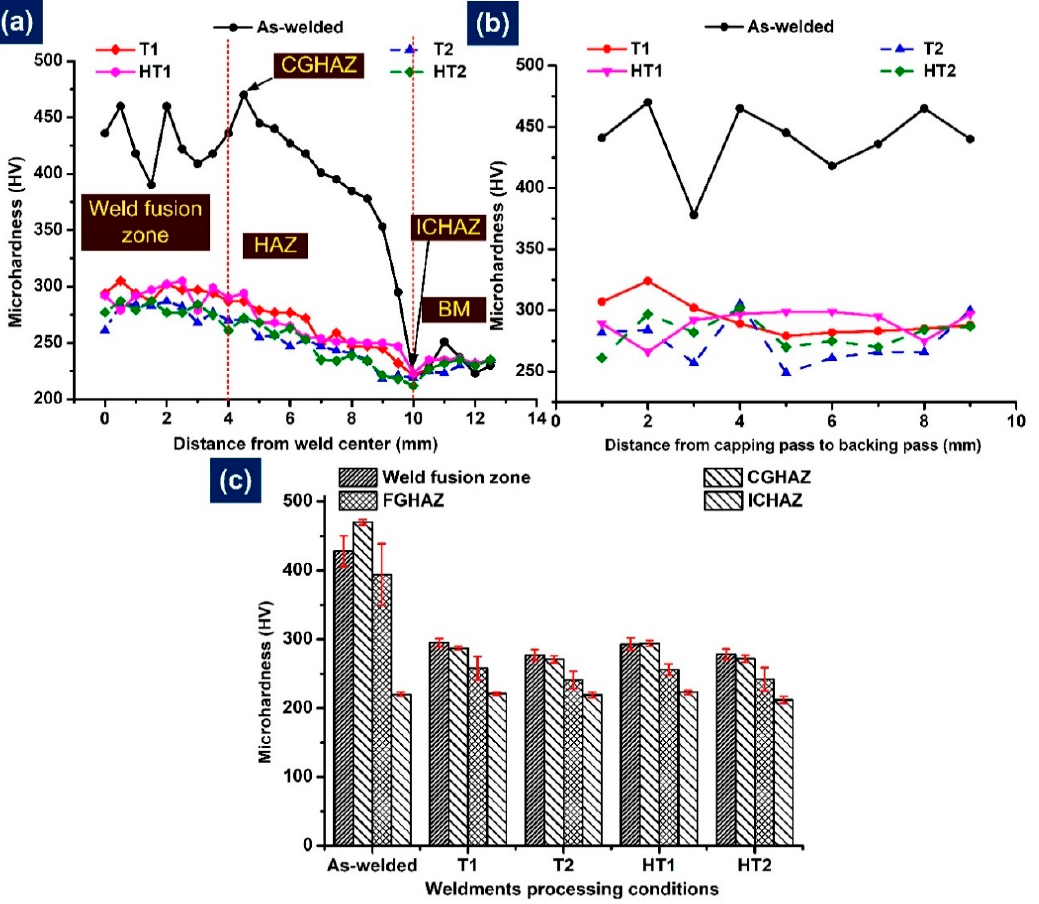
Figure 17. ( a ) Hardness profiles along the weldments, ( b ) hardness profiles, and ( c ) hardness of weldments after different heat treatment conditions.